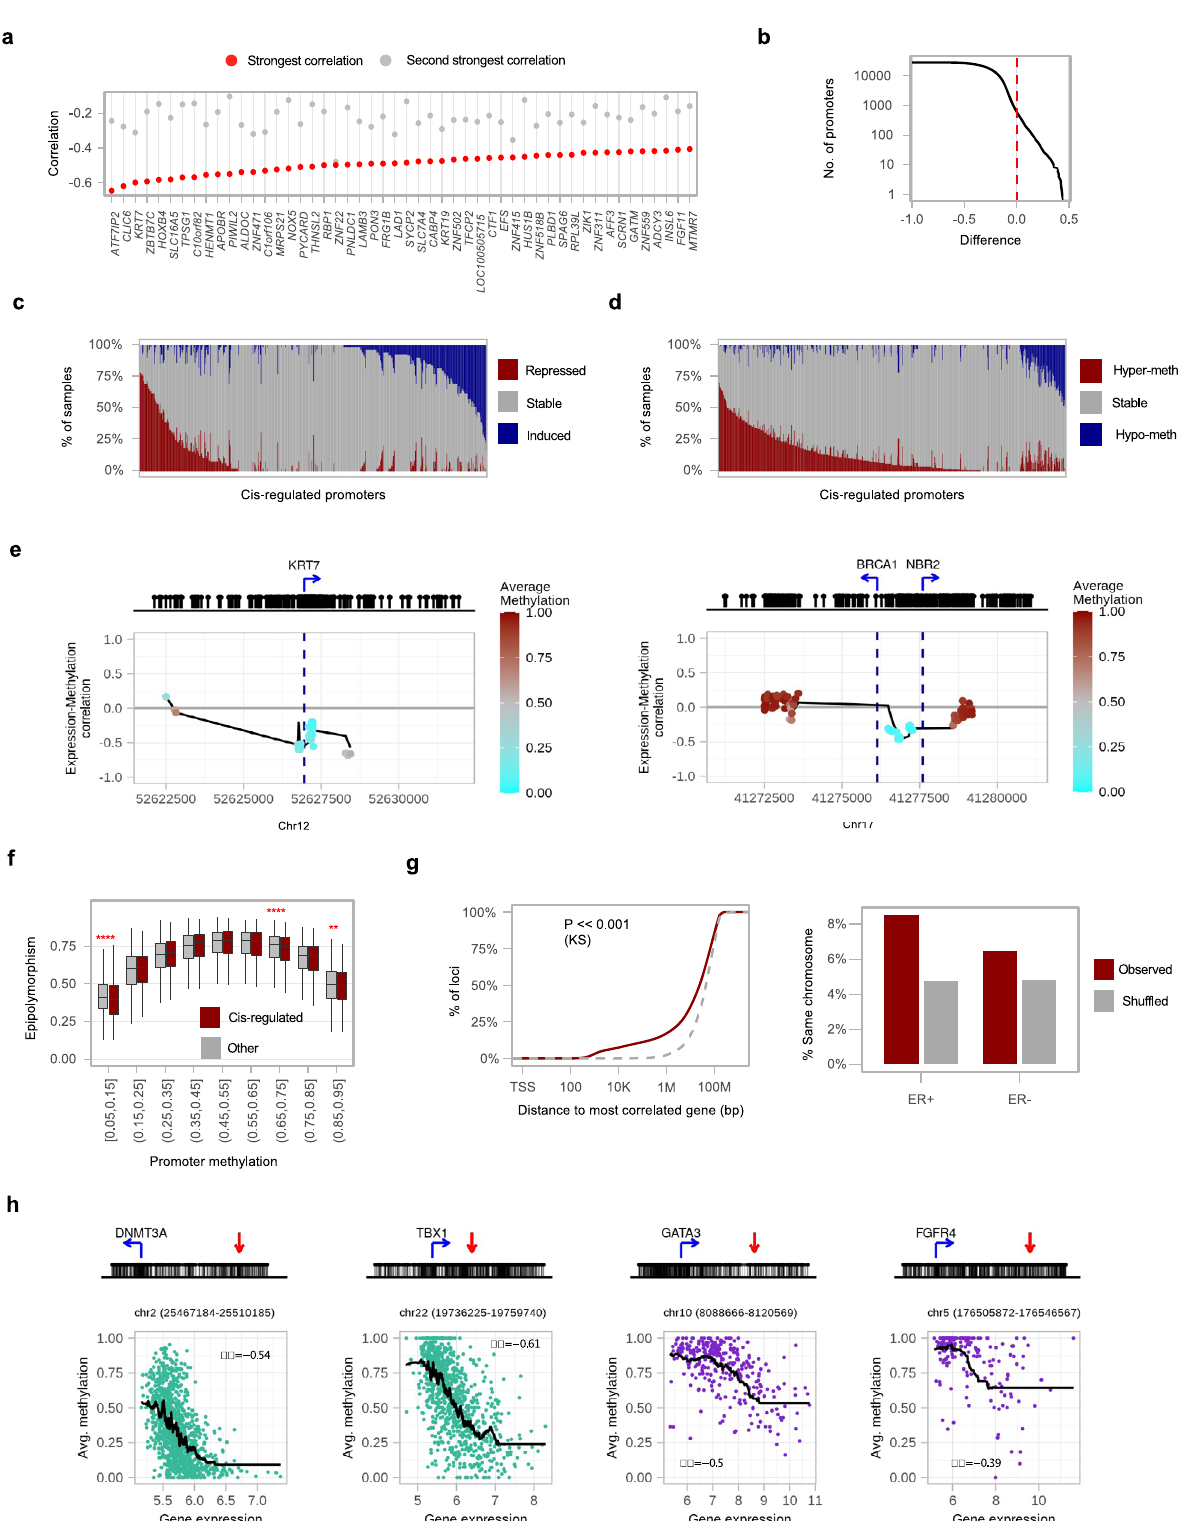
for genes showing both repression and induction in tumors compared to normal, in association with their hypermethylation (Fig. 3c, d). To fi nd which of these localized and speci fi c cis - regulated genes are part of larger co-regulated gene mod- ules (Fig. 3e), we computed correlation of gene expression pro fi les (Extended Data Fig. 8c) and con fi rmed most genes in the group were not part of larger expression clusters (392 out of 423 with